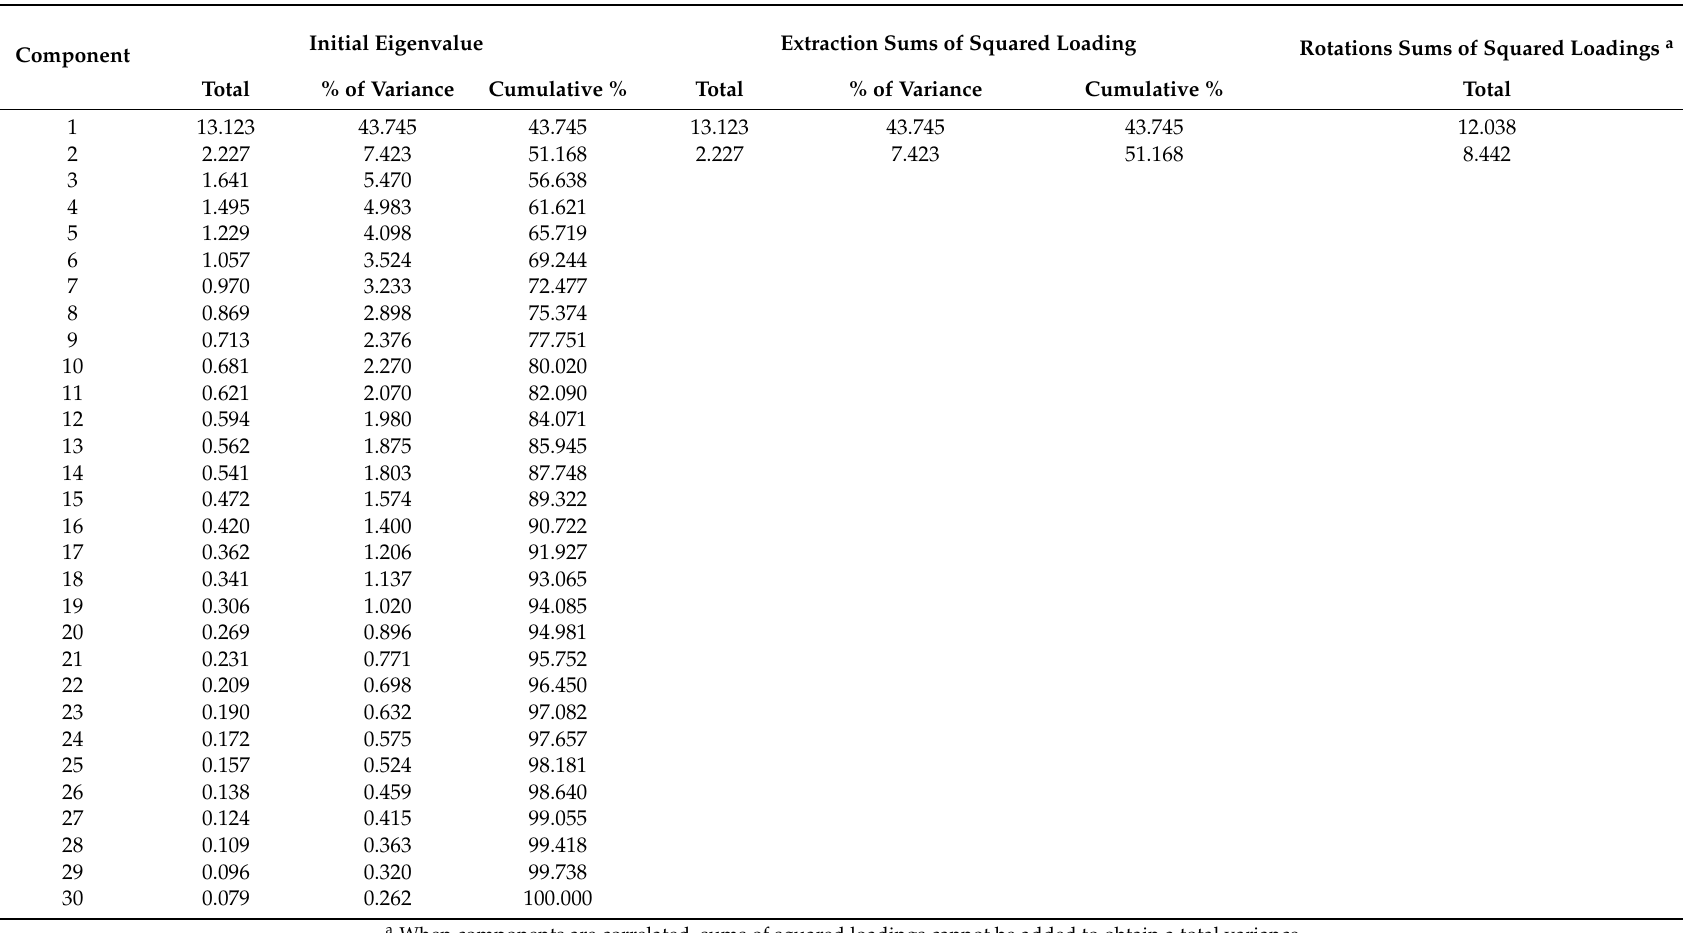
Table 5. Principal component of factors that consist of initial Eigenvalue and Extraction sums of squared loadings to determine factors to be retained for further analysis.